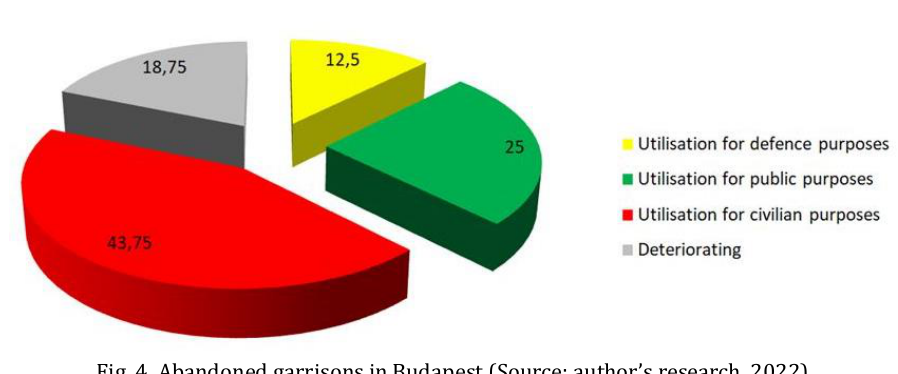
Fig. 4. Abandoned garrisons in Budapest (Source: author’s research, 2022) Table 3. Condition of abandoned garrisons in Budapest (Source: author’s research,